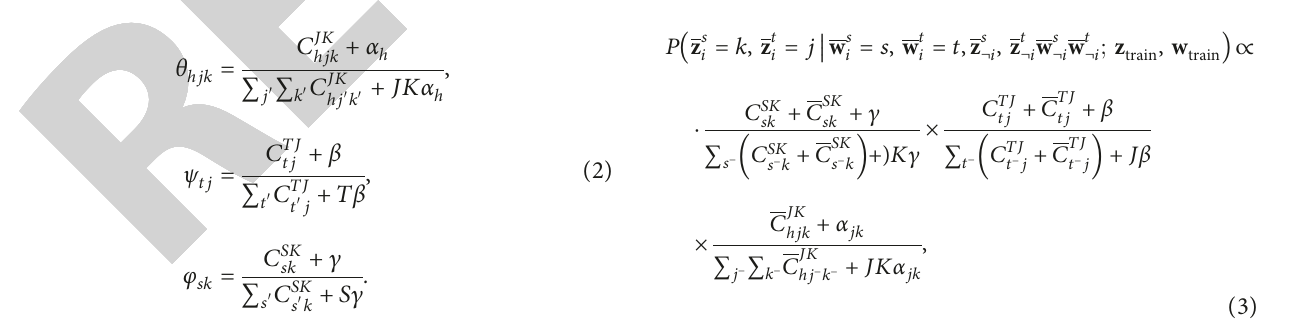
Figure 2: Graphical representation of the model. Single circles indicate random variables, double circles indicate observed variables, boxes indicate replicates of the data, and arrows represent the dependency between entities.